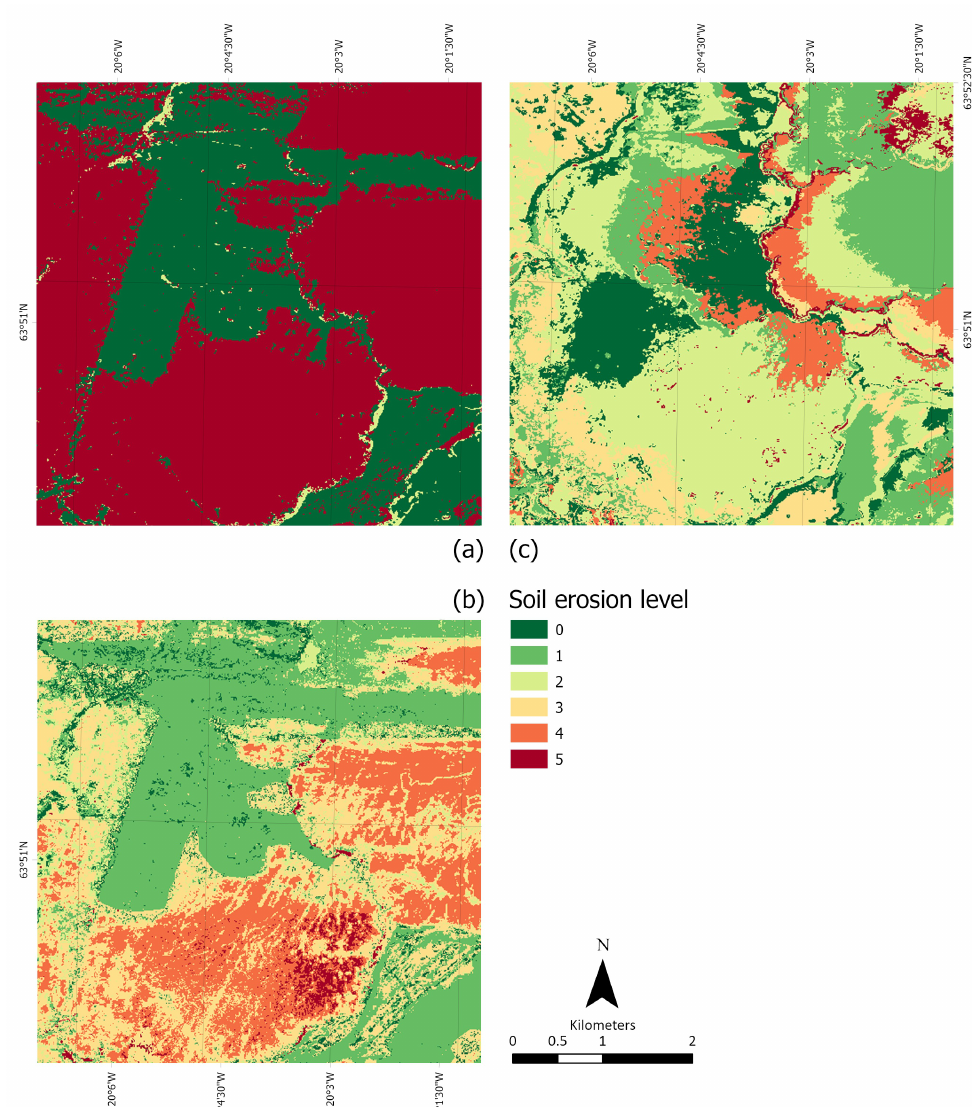
Figure 4. Predictions for soil erosion level made by the ML models: ( a ) MLP predictions ( b ) RF predictions ( c ) SVM predictions. The erosion risk level is color-coded from Class 0 (very low erosion risk) to Class 5 (high erosion